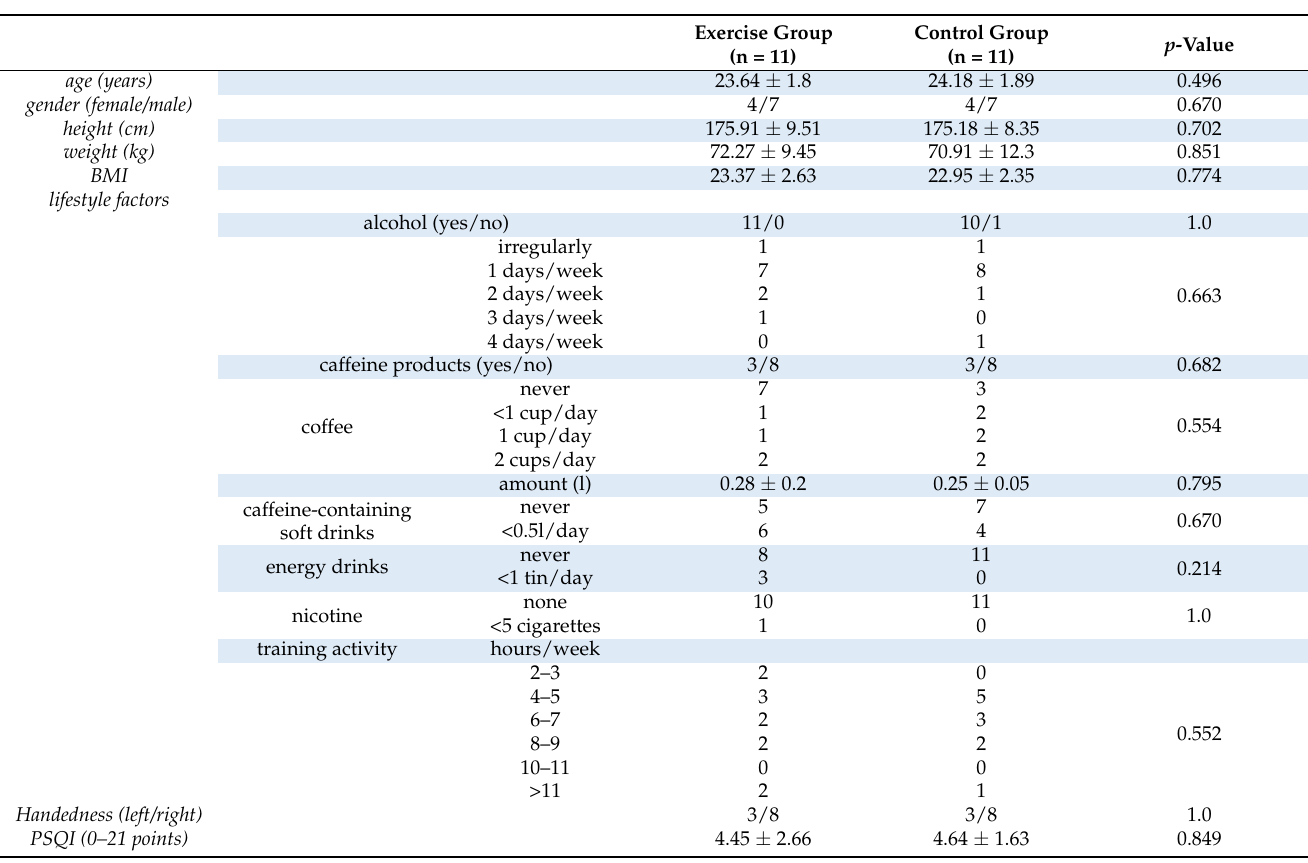
Table 1. Demographics . Data are reported as mean ± standard deviation, or in counts (n). Statistics between continuous variables was calculated with unpaired t -tests (all parametric), and between categoric variables with chi-square